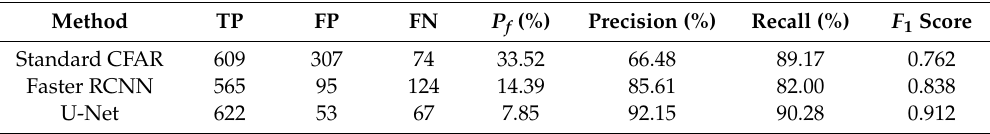
Figure 7. Illustrations of CP SAR images, corresponding label images, and detection results. The false alarm was marked by a red rectangle. alarm was marked by a red rectangle. Table 3. Detection performance comparison between di ff erent methods (using CP SAR Table 3. Detection performance comparison between different methods (using CP SAR images).